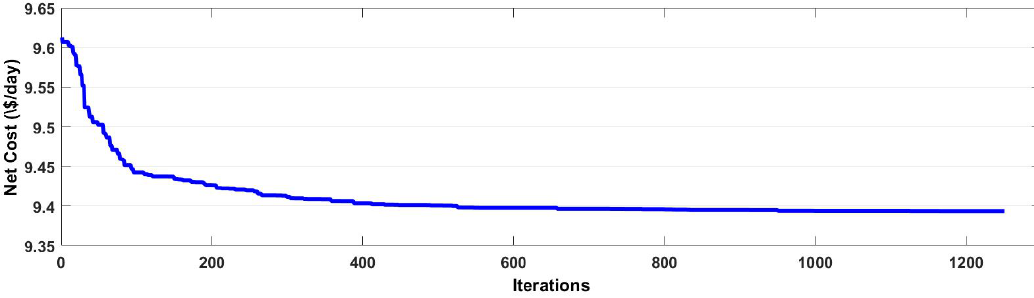
Figure 13. Convergence of